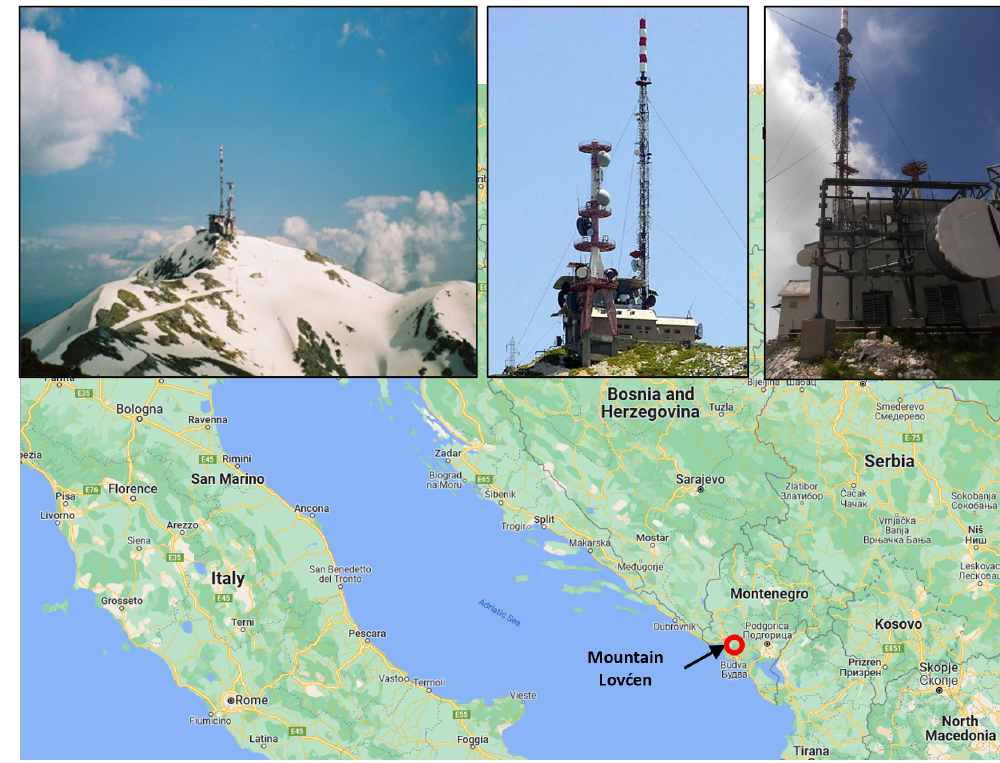
Figure 2. Observation site